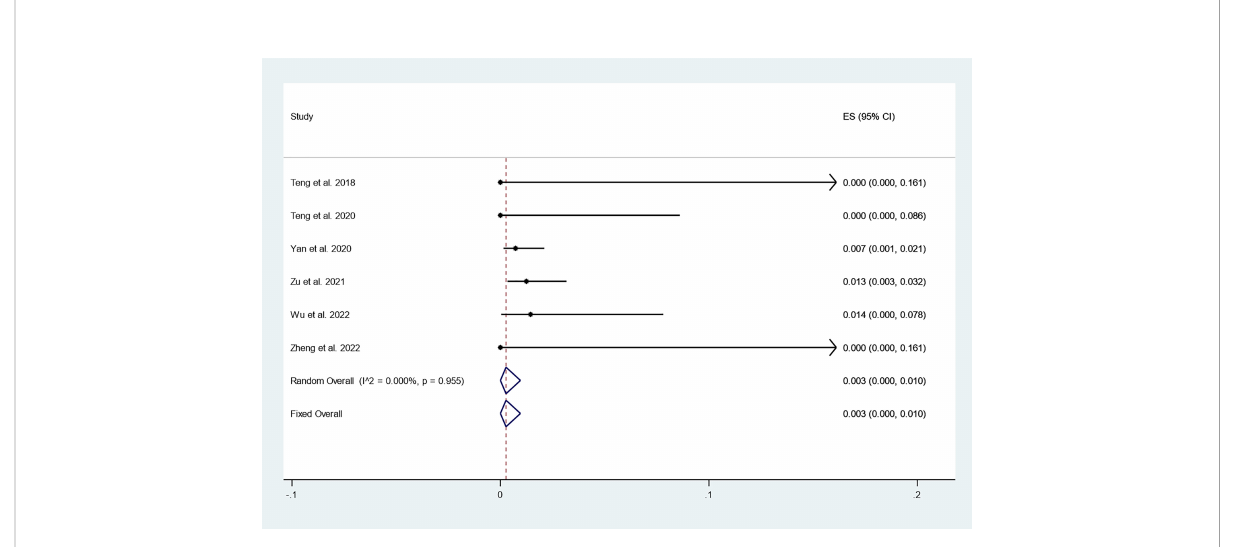
FIGURE 6 Incidence of newly discovered PTC after thermal ablation at 3-year